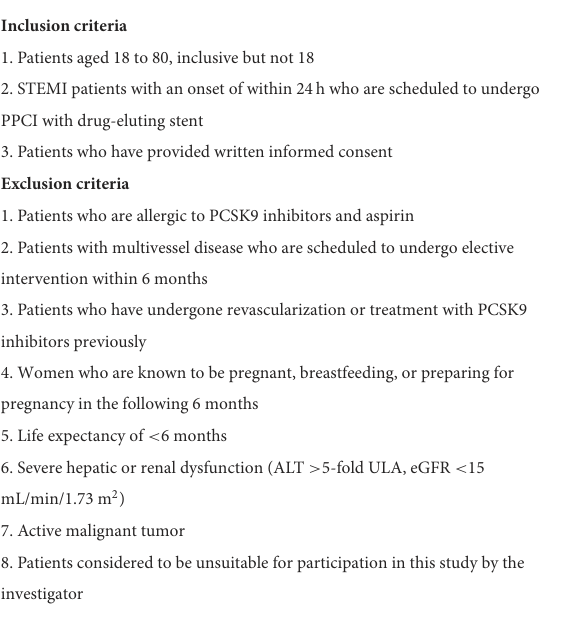
TABLE 1 Study inclusion and exclusion